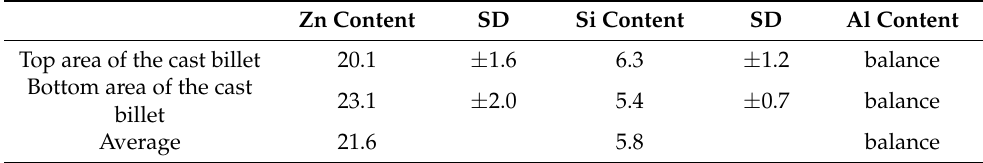
Table 4. Chemical composition of the cast AlZn22Si6-billet in at.%; SD: standard deviation. Zn Content SD Si Content SD Al Content Top area of the cast billet 20.1 ± 1.6 6.3 ± 1.2 balance Bottom area of the cast 23.1 billet Average